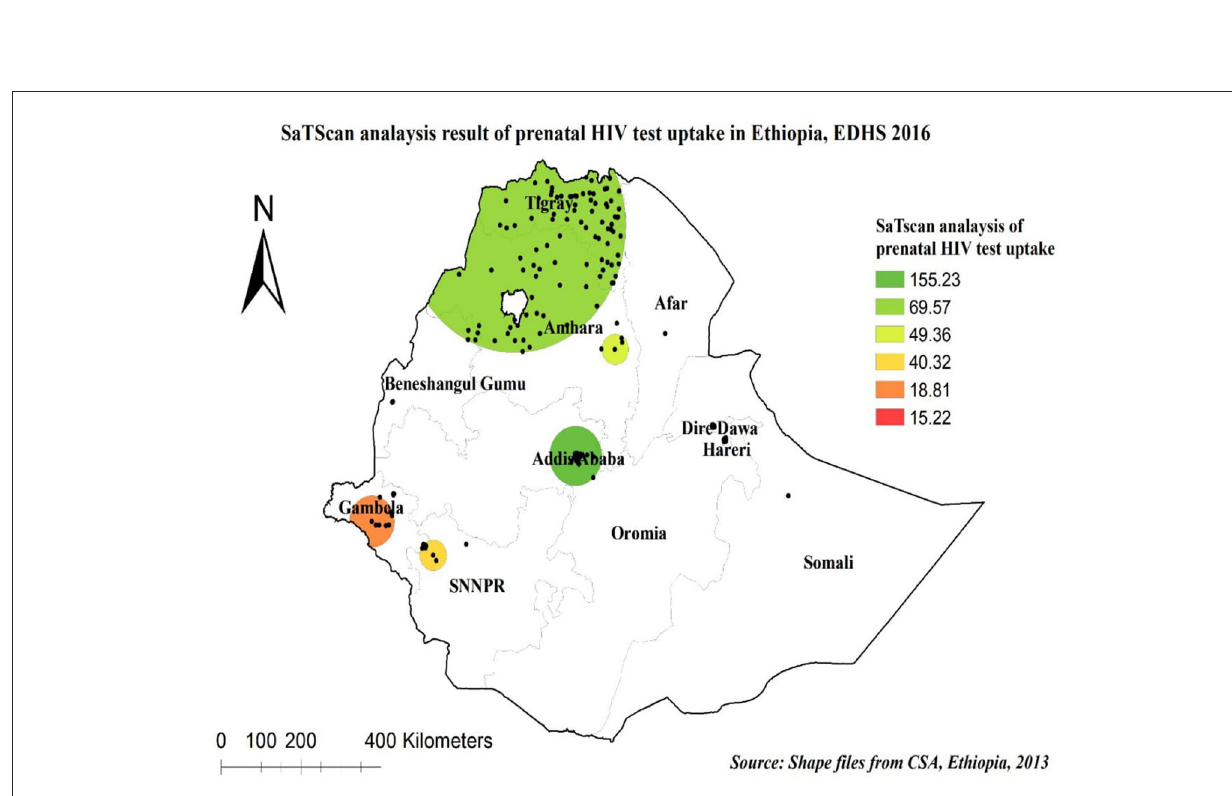
FIGURE4 SaTScan analysis of prenatal HIV test uptake in Ethiopia,